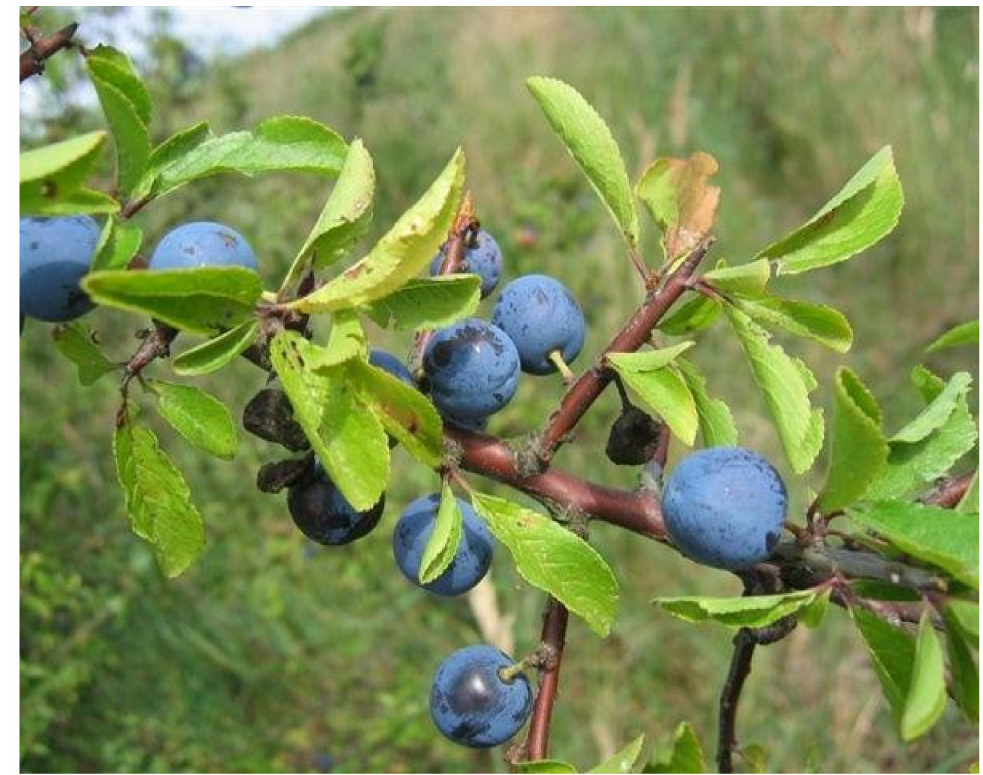
Figure 4. Prunus spinosa Trigno ecotype (PsT) plant, from Bagnoli del Trigno, Molise,